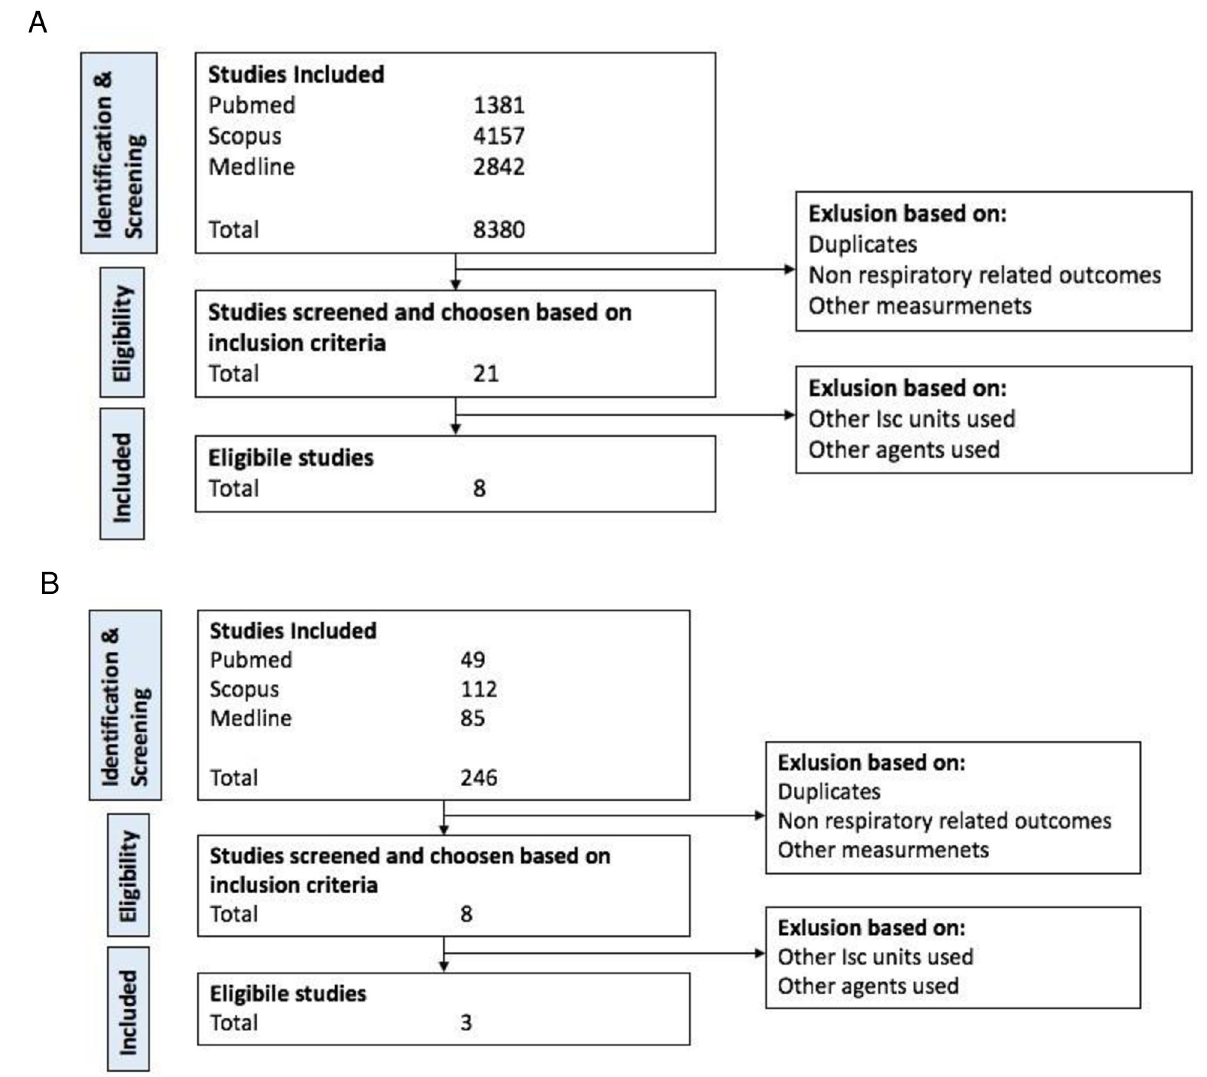
Fig 2. Study selection process of Animal Models studies (A) and iPSCs studies